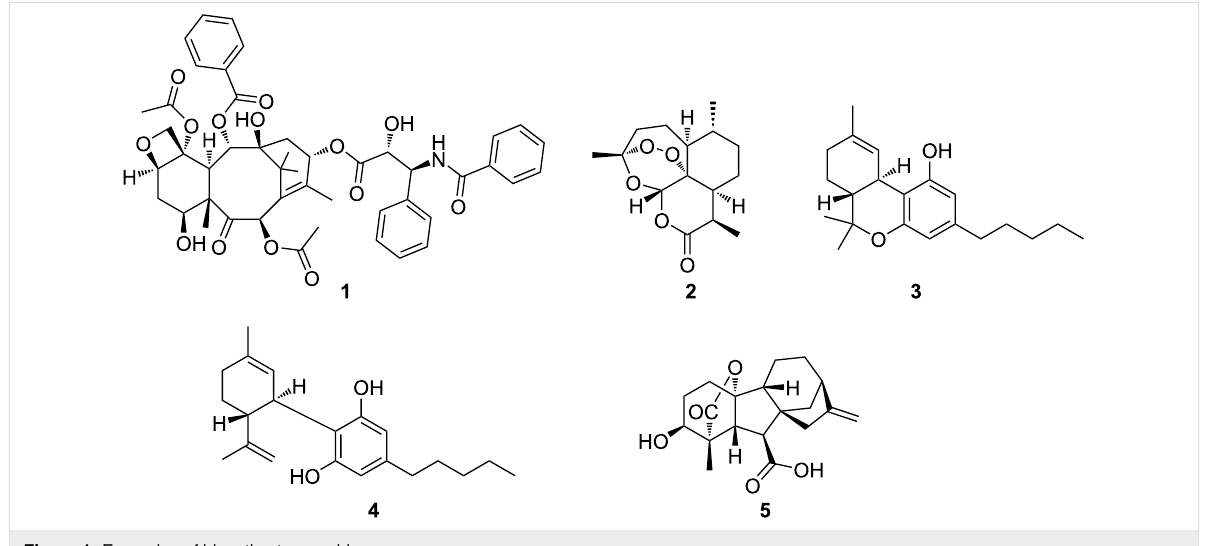
Figure 1: Examples of bioactive